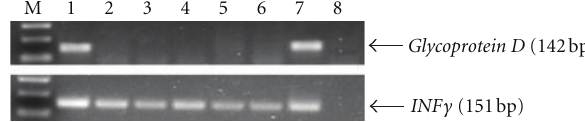
Figure 2: Absence of HSV DNA from normal heart tissues. HSV and IFN- γ PCR in representative cases with normal heart tissues.